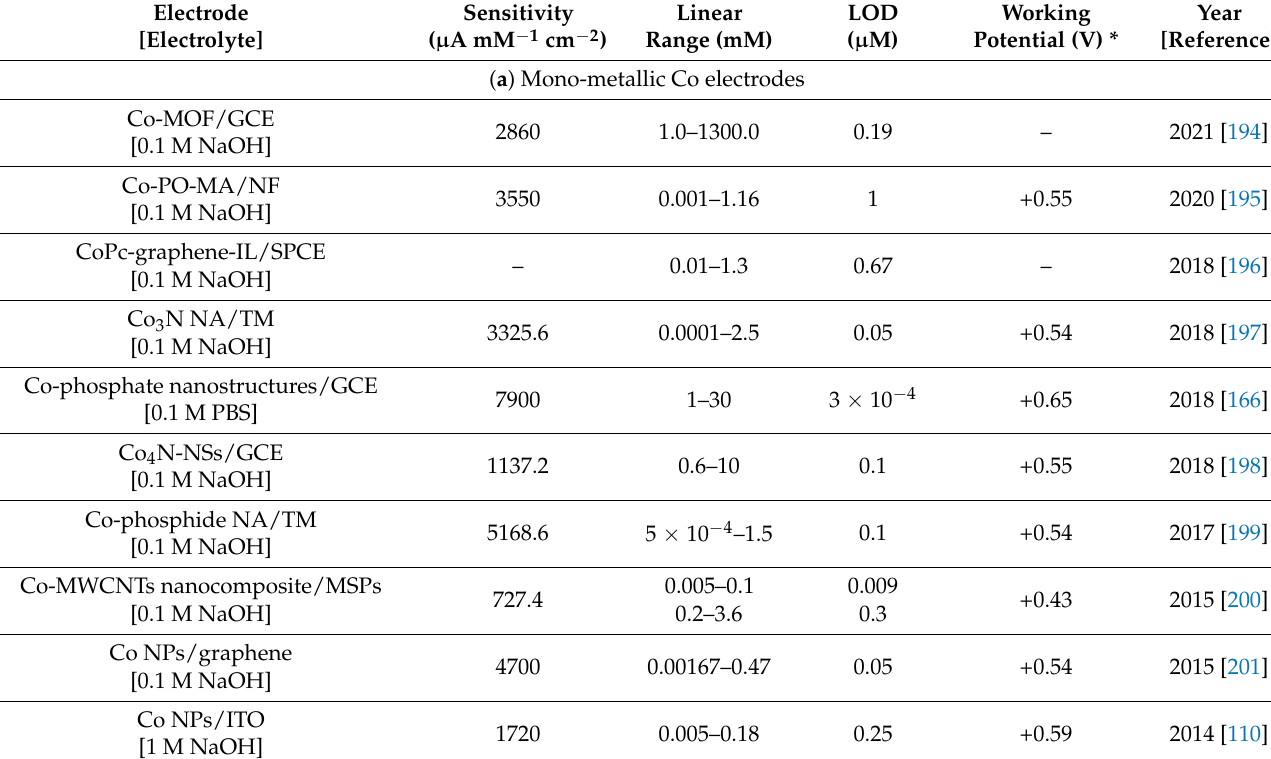
Table 3. Electrodes for the sensing of glucose by the transition mono-metallic ( a ) Co, ( b ) Cu, and ( c ) Ni materials within this decade. The performances are compared in terms of sensitivity, linear range, limit of detection (LOD), and working potential. The working potentials are based on the reference electrode of